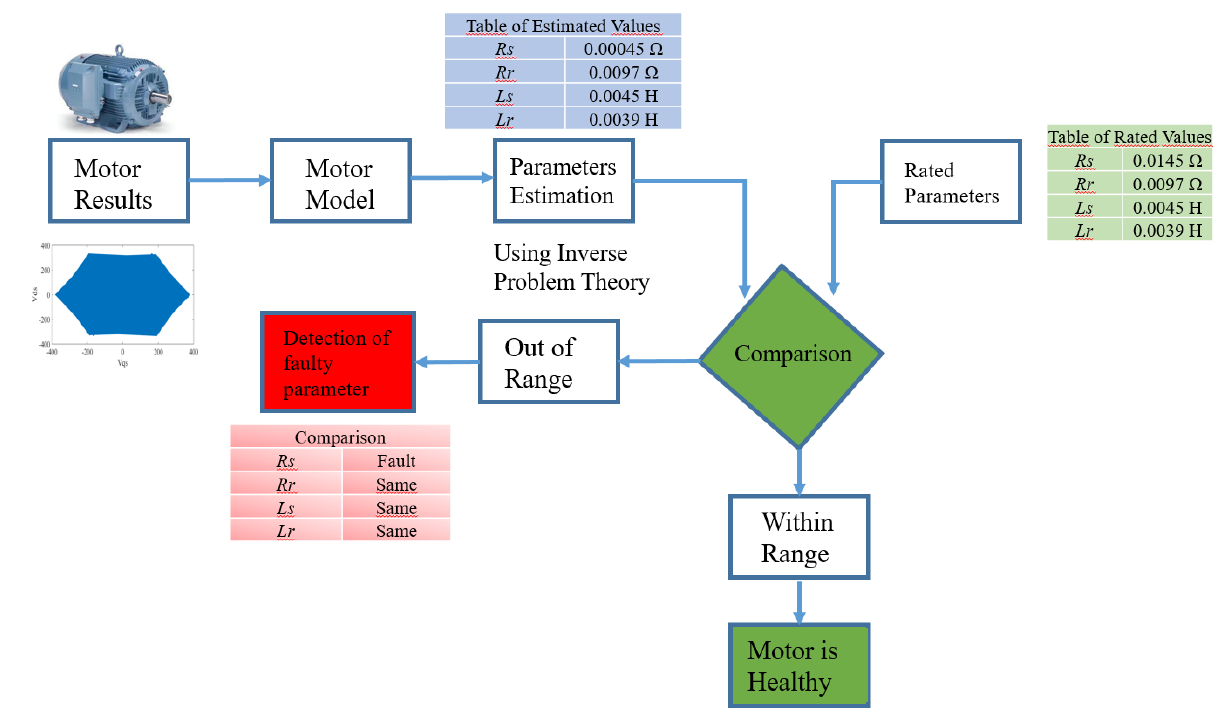
Fig. 4. Schematic diagram of the proposed inverse model for fault